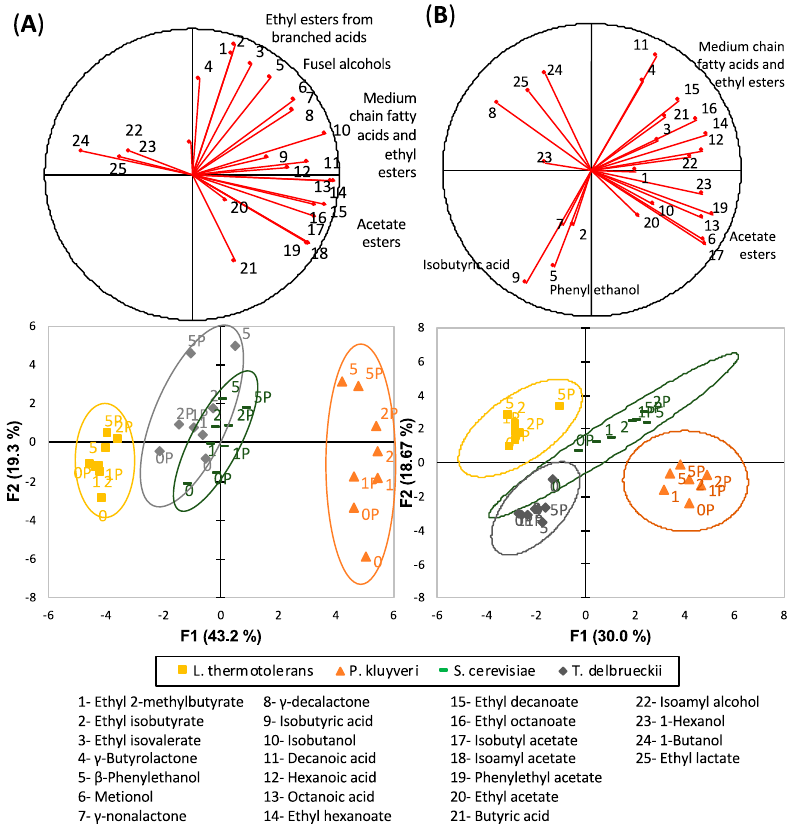
Figure 2. Principal component analysis carried out with fermentative aroma compounds quantified in ( A ) Riesling and ( B ) Garnacha from all of the fermented samples. The plot shows the projection of variables (top plot) or samples (bottom)—the average of two biological replicates—in the plane formed by the first two components, which retained 62.5% and 48.7% of the original variance, respectively. The numbers in the samples refer to the weeks of anoxic storage at 50 ◦ C, and ‘P’ refers to the presence of